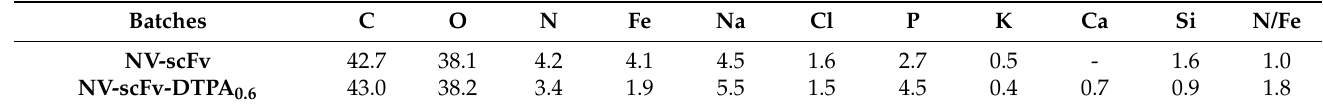
Table 1. XPS quantification (at. %) on NV-scFv and NV-scFv-DTPA 0.6 sample